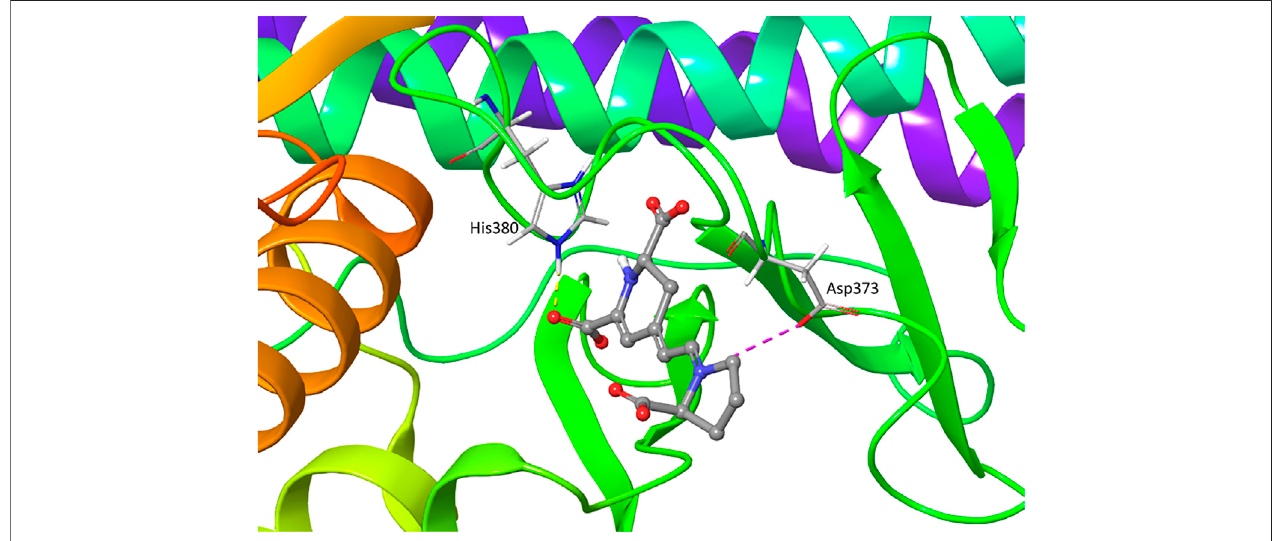
FIGURE4| IFDposeofIndicaxanthinintheinactiveChainAallostericbindingsite.H-bondsinteractionsarerepresentedinyellowdashes,thesaltbridgesinpurple dashes.